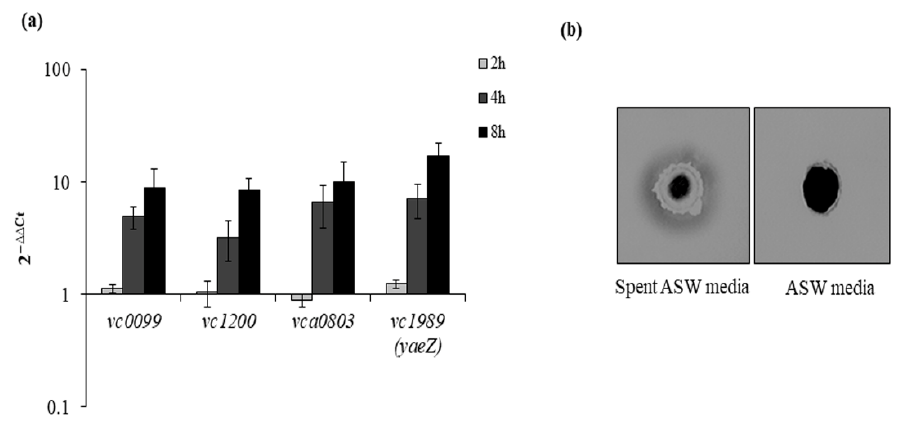
Figure 6. Protease expression at mRNA and protein level during recovery. ( a ) We checked the mRNA expression of serine proteases such as vc0099 , vc1200 , vca0803 and vc1989 ( yaeZ ) in a time-dependent manner (4 h, 8 h, 16 h) using dnaK as reference gene. ( b ) Skim milk plate assay for the detection of protease secretion during recovery from VBNC state. Protease activity on 1% skim milk